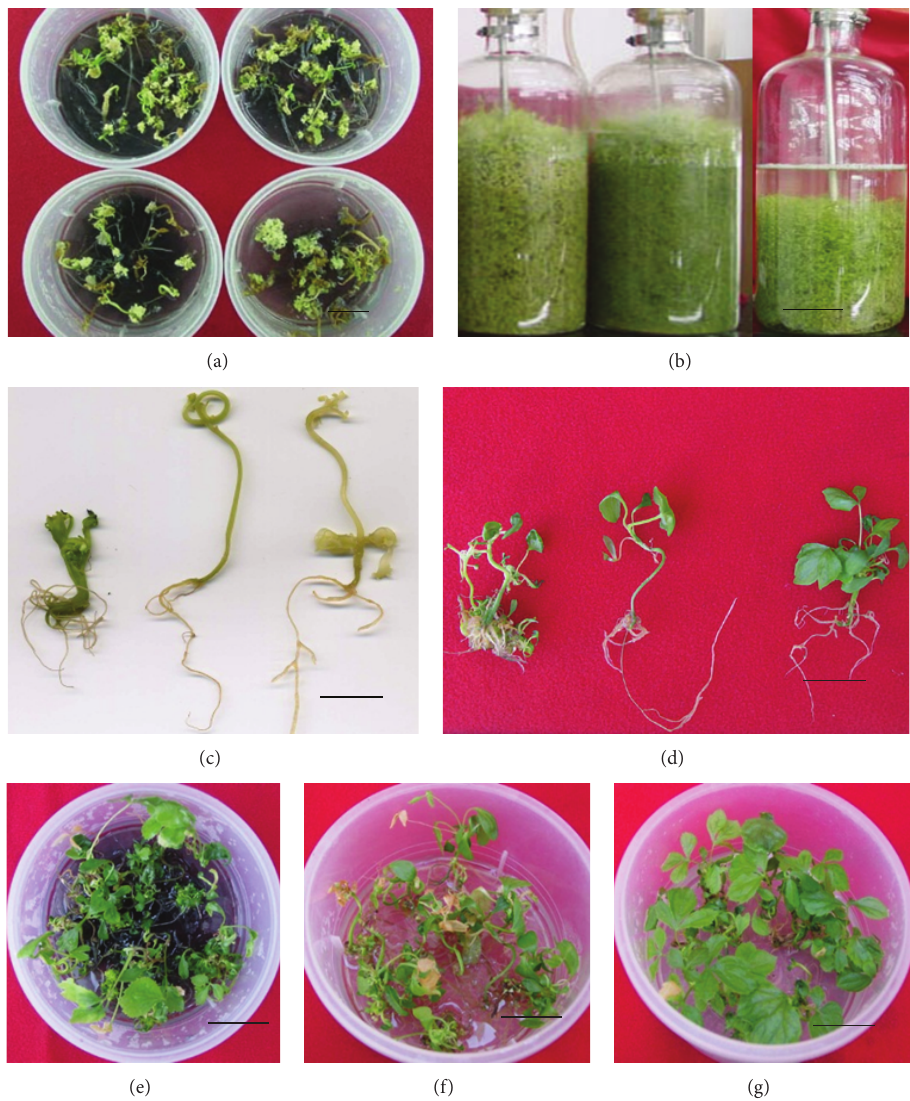
Figure 1: Bioreactor culture of agar medium induced heart-shaped and torpedo-shaped secondary somatic embryos of Siberian ginseng and plantlet conversion. (a) Numerous secondary SEs induced from germinated primary SEs on 1/3 MS medium without PGRs. Bar = 1cm. (b) Germinated HS2 (left), HS3 (middle), and TS2 (right) SEs production in a 10l bubble column bioreactor. Bar = 10cm. (c) Germinated TS2 (left), HS2 (middle), and HS3 (right) SEs production in a 10l bubble column bioreactor. Bar = 2 cm. (d) Plantlets derived from germinated HS3 (left), HS2 (middle), and TS2 (right) SEs. Bar = 4cm. Plantlet conversion of germinated HS3 (e), HS2 (f), and TS2 (g) SEs. Bar = 2